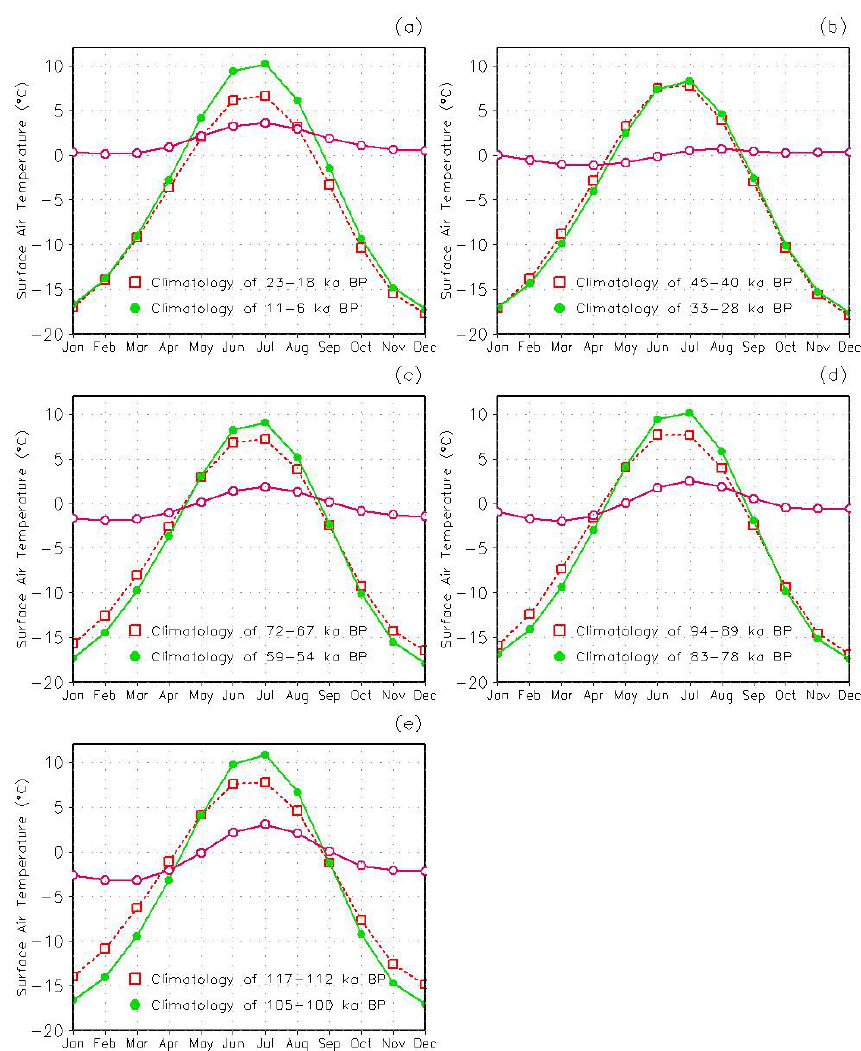
Fig. 8. Annual cycles of the Guliya SAT in the extreme warm (closed circles) and cold phases (open squares) of the August–September Guliya SAT and their difference (warm phase minus cold phase: open circle). The times of the extreme warm and cold phases are indicated in each